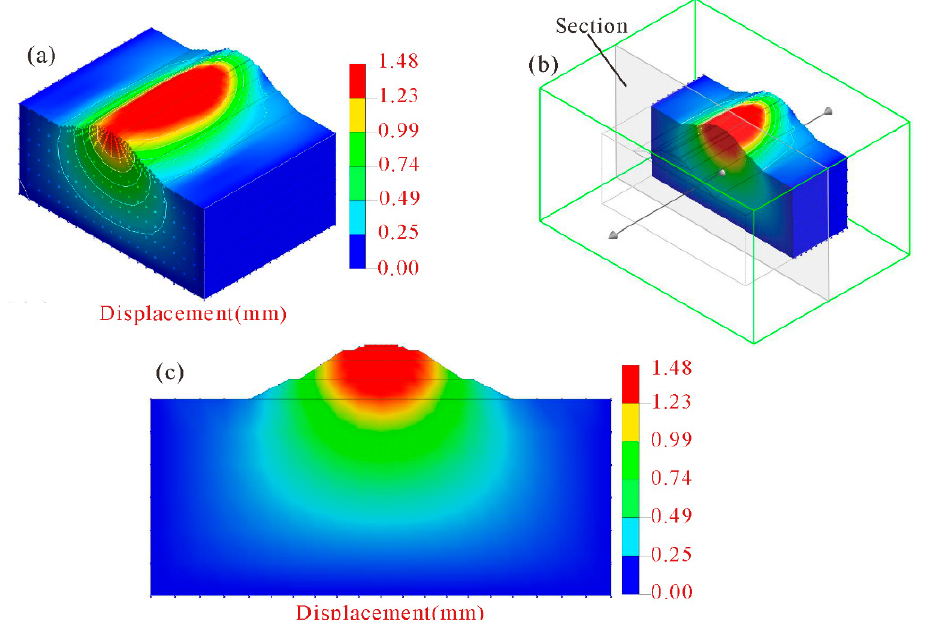
Figure 11. Settlement contour map of unimproved high-speed railway subgrade. ( a ) Three-dimensional contour map; ( b ) schematic diagram of section position; ( c ) section diagram of maximum settlement.